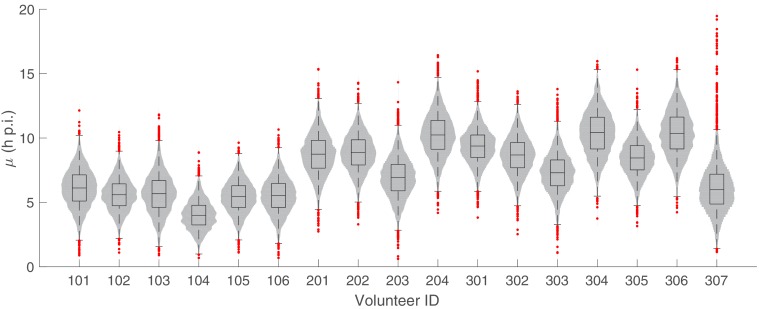
The marginal posterior distributions of the individual parameter of µ (mean of the initial parasite age distribution) for all 17 volunteers.The violin plots (gray area) show the distributions of 5000 posterior samples. Box plots show the 25%, 50% (median) and 75% quantiles with outliers indicated by red dots. Relevant details of the individual parameter are provided in the Materials and methods in the main text.